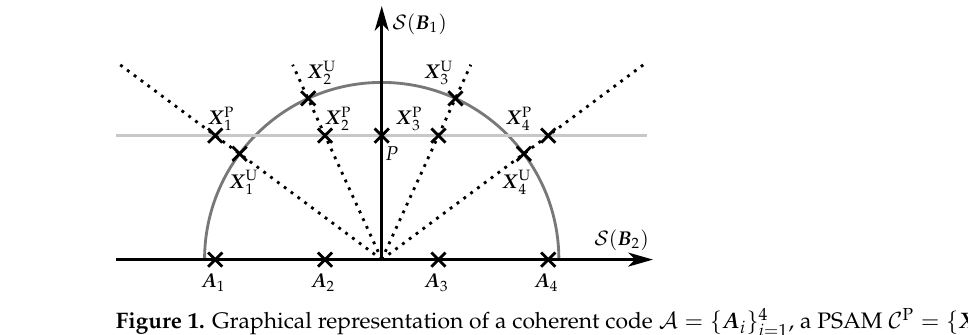
Figure 1. Graphical representation of a coherent code A = { A i } 4 } 4 USTM C U = { X U . The signals of both the PSAM and the USTM have the same mean power and i i = 1 span the same subspaces, which are drawn with dotted